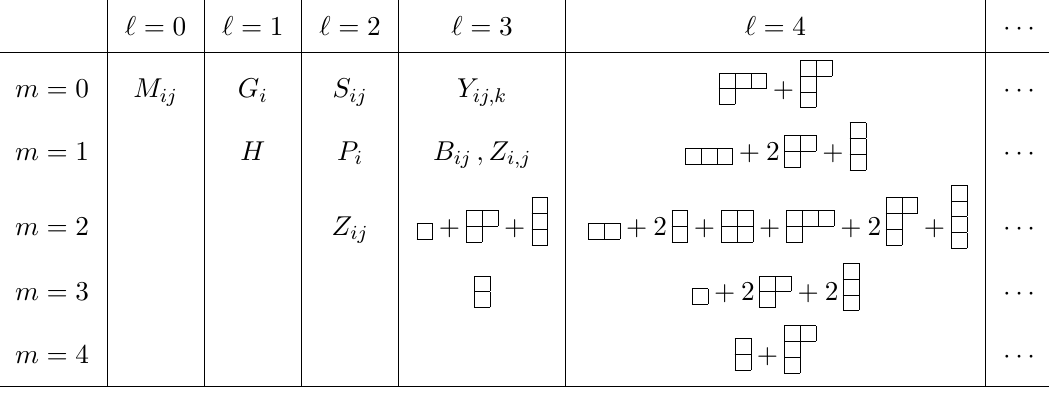
Table 2 . The free Lie algebra extension of the electric Maxwell Galilei algebra, generated by G i , H and Z ij (together with the rotation generators M ij ). The electric (cid:12)eld generator Z i corresponds to a linear combination of the single box and the traceless part of the hook Young tableau at ( ‘; m ) = (3 ;